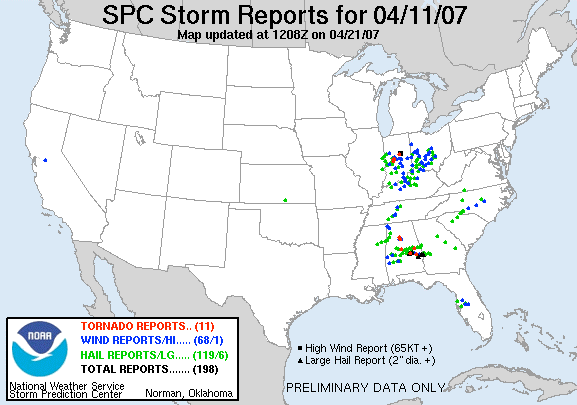
Figure 1. Storm Prediction Center (SPC) map of